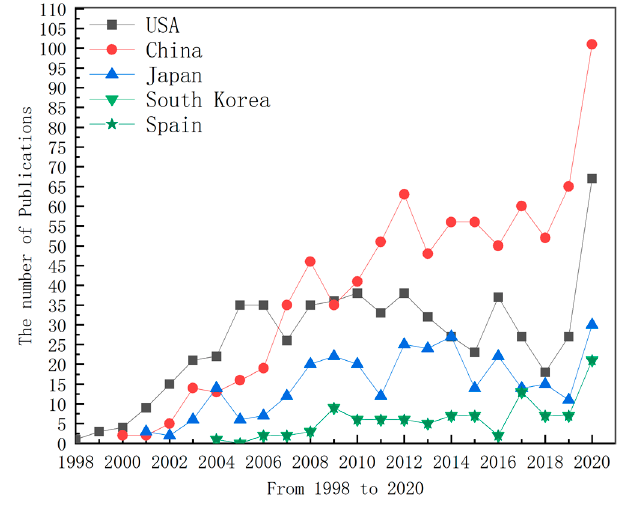
Figure 4. The national trend of the number of top five papers published from 1998 to 2020. To a certain extent, studying the number of cooperative publications between countries can reflect the communication between countries and whether the two countries are at the same level in this field. Table 2 shows the top ten countries that have cooperated with the United States and China in publishing articles. From the table, it can be seen that the United States and China have cooperated the most extensively with each other. The United States has cooperated with China in publishing 113 articles, accounting for 21.81% of the total published articles in the United States and 42.32% of the total published articles in China. It can be seen that the United States occupies a large proportion in Chinese co- operative publishing. At the same time, the articles published by the United States in co- operation with other countries are diverse. The second country to publish articles in co- operation with the United States is France, which has published 49 articles in cooperation with the United States, accounting for 9.46% of papers, and the third country is Spain,